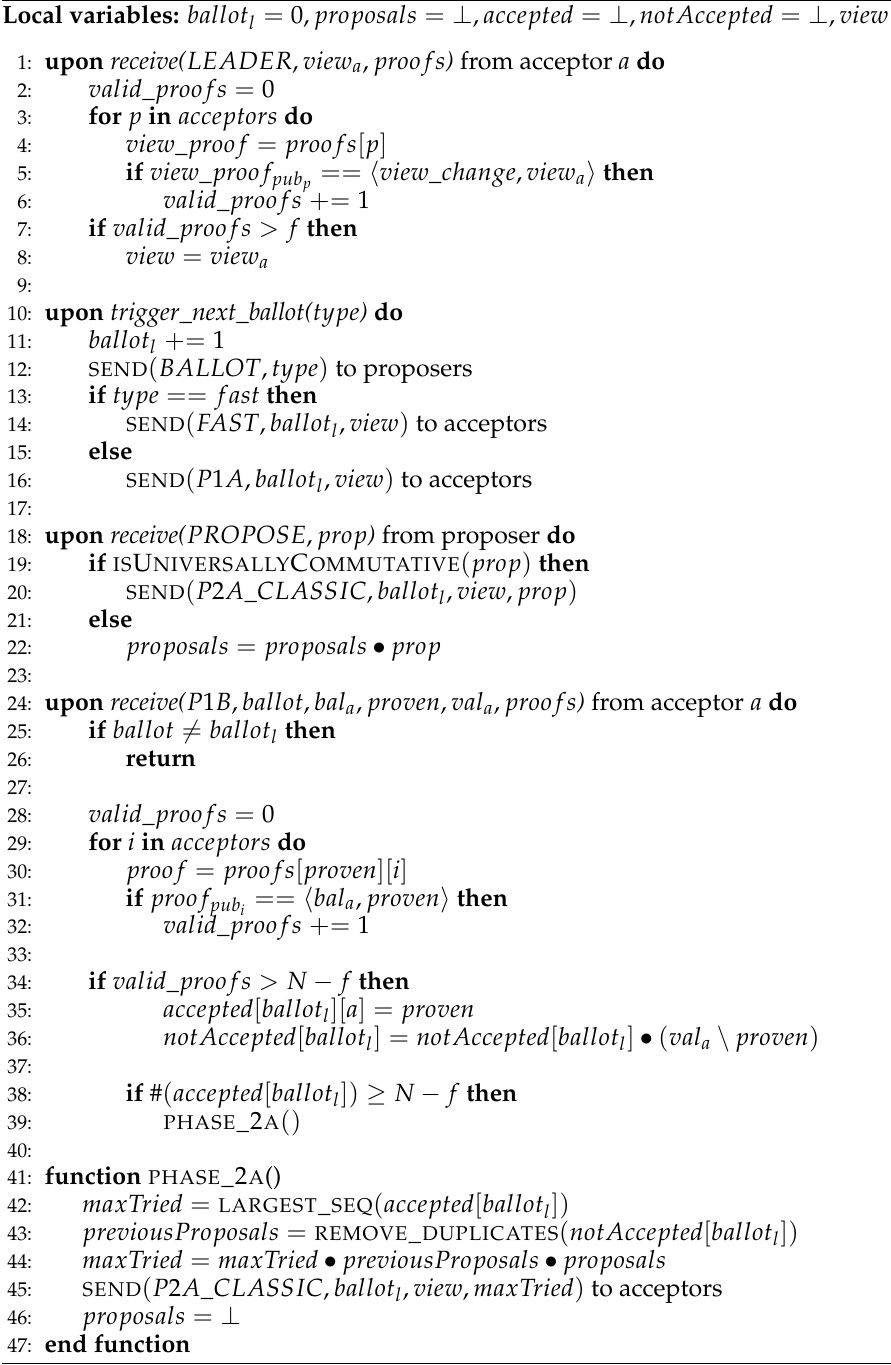
Algorithm 7 Byzantine Generalized Paxos—Leader